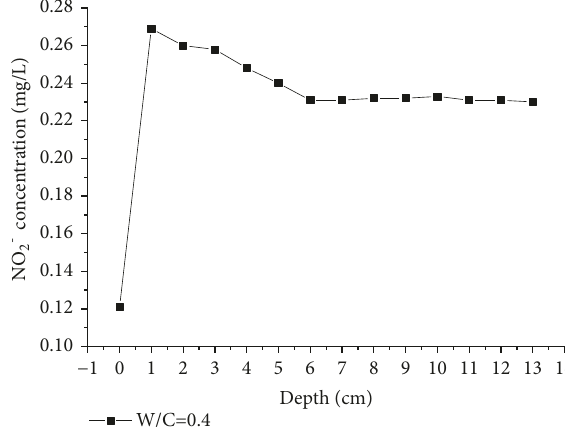
Figure 5: NO 2 - concentration under Cl - attack (w/c=0.4).